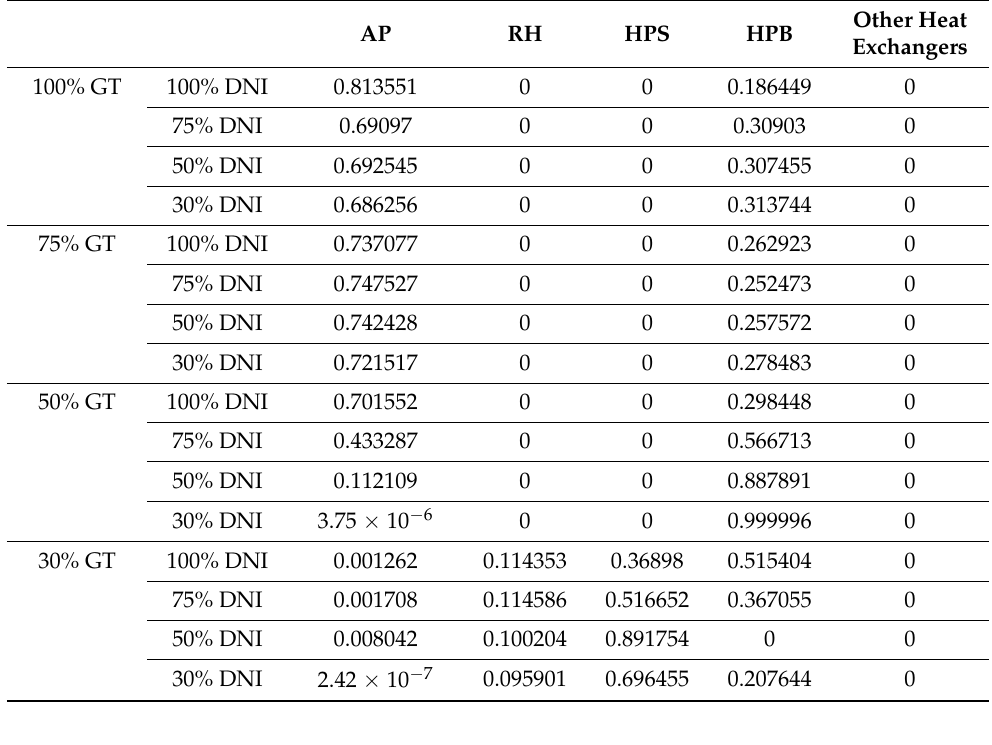
Table 8. The integration proportions of different work conditions based on the maximum solar photoelectric efficiency.